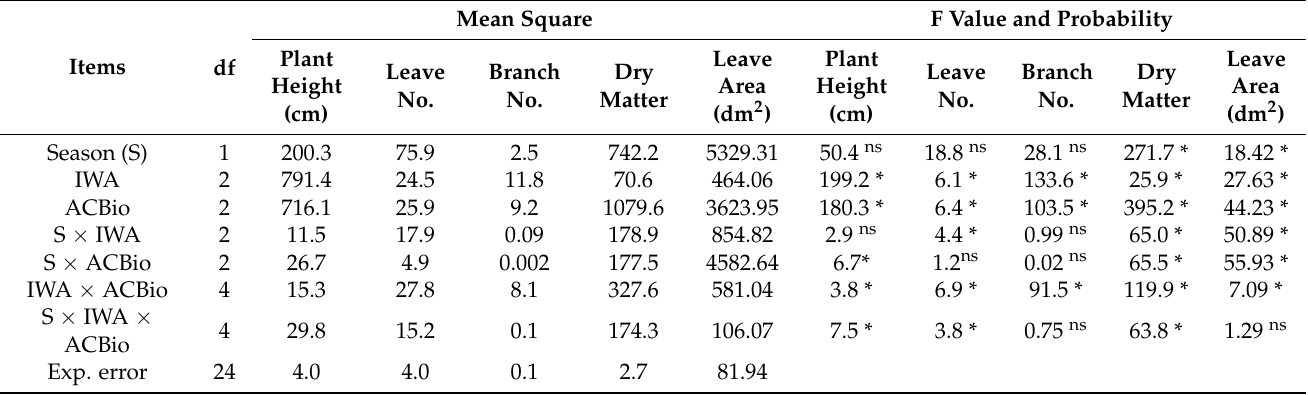
Table 6. Mean square, F value, and probability for plant height, leaf number, branch number, dry matter, and leaf area.